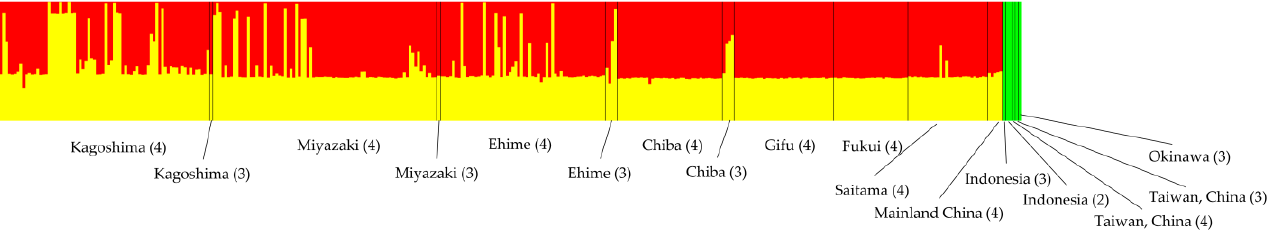
Figure 5. Bayesian clustering in each of the 11 populations calculated by PolyGene software, K = 3 (red, yellow, and green). The number in () after the population is the ploidy estimated by the R package “ polysat ” .